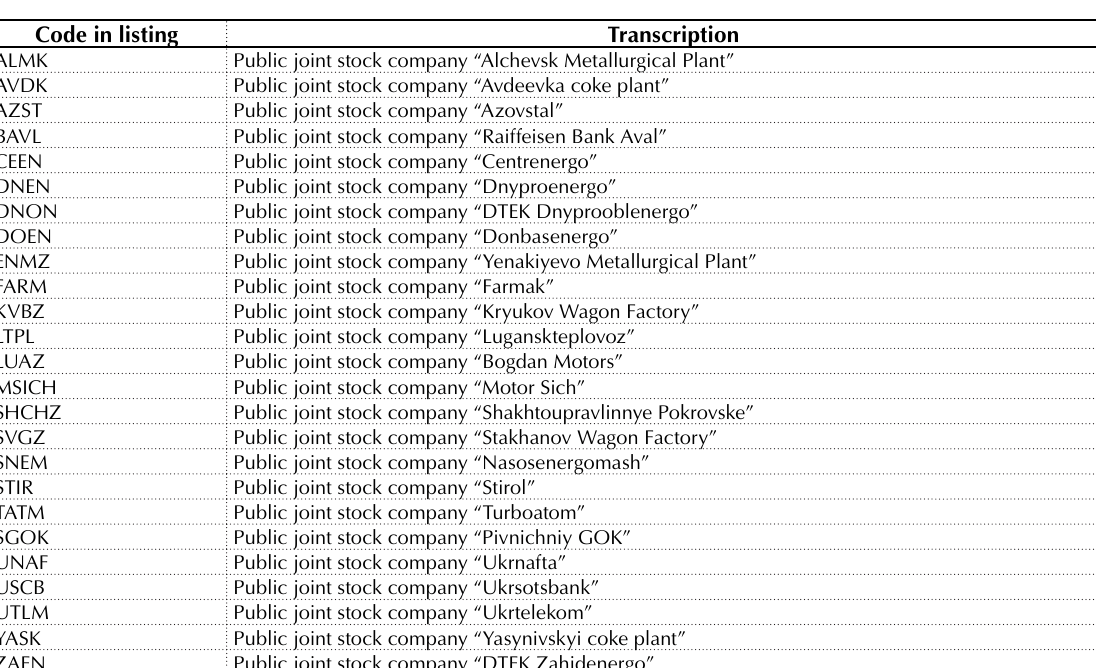
Table В 1. Transcription of the codes in listing (Ukrainian